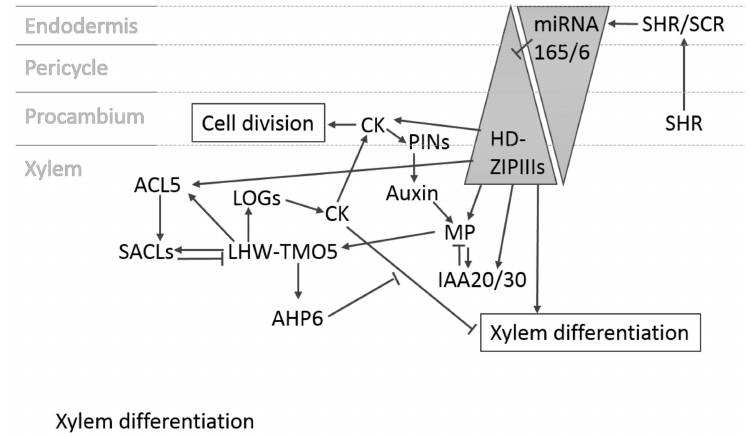
Figure 3. Xylem differentiation in the primary root. HD-ZIP IIIs are important promotors of xylem differentiation. Their level is regulated by a gradient of inhibitory miRNA165/6. miRNA165/6 levels are defined by SHORTROOT (SHR)/SCARECROW (SCR) dimer presence. The gradient is established by SHR diffusion from its production area in the procambium to the endodermis, where it forms the dimer with SCR that promotes miRNA165/6 expression. This results in a miRNA165/6 gradient with highest levels in the endodermis and an inverse gradient for HD-ZIP IIIs that promote xylem differentiation. The HD-ZIP IIIs induce MP and IAA20/30 . They also enhance ACL5 expression and CK (cytokinin) production. ACL5 induces translation of SUPRESSOR OF ACAULIS LIKE (SACL) genes that inhibit LHW–TMO5 dimerization and thus LOG expression, lowering the CK levels. The dimer also induces the CK signalling inhibitor AHP6 , inhibiting the negative effect of CK on xylem differentiation. In the procambium, the CK inhibitory effects mediated by the HD-ZIP IIIs are not present, which leads to higher CK levels and signalling, resulting in cell division rather than xylem differentiation. CK induces PIN activity, pumping auxin out of the procambium. This causes an auxin maximum in the xylem axis, which subsequently induces MP